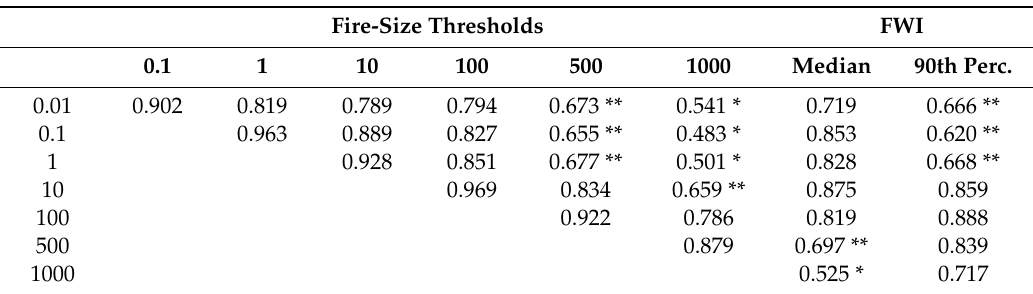
Table 4. Correlation matrix ( r values) between FWI thresholds for each fire size class, and between the latter and the median and 90th percentile of the FWI ( n = 18). All correlations are significant at p < 0.001, except * ( p < 0.05) and ** ( p < 0.01).